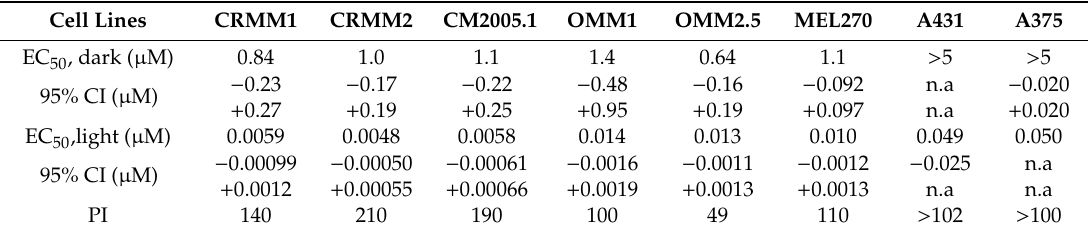
Table 1. Three conjunctival melanoma cell lines, three uveal melanoma cell lines and two control cell lines were tested in an SRB cell viability assay, after exposure to TLD1433 with or without 19 J.cm − 2 green light exposure for 15 min (21 mW / cm 2 , 19 J.cm − 2 ). Cell growth inhibition e ff ective concentrations (EC 50 , in µ M) and 95% confidence intervals (95% CI, in µ M) were obtained. The photo index (PI) was calculated as EC 50 , light divided by EC 50 ,